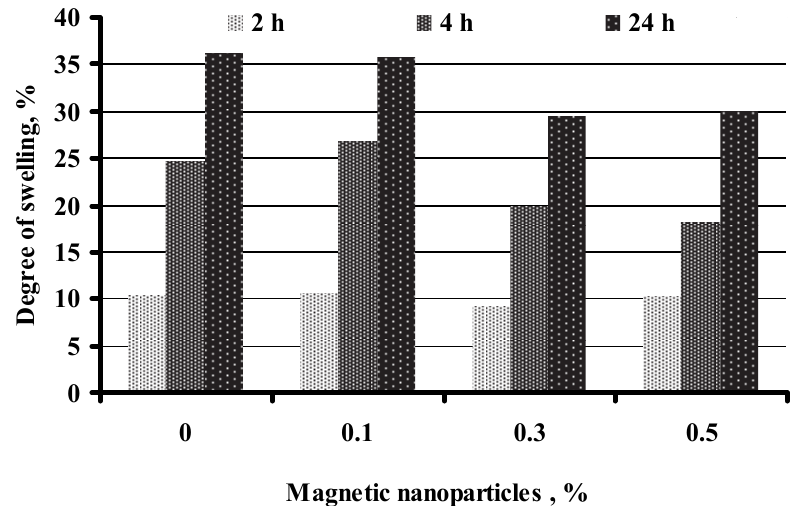
Figure 9:Changes of degree of swelling (volume) in dependence on the amount of magnetic